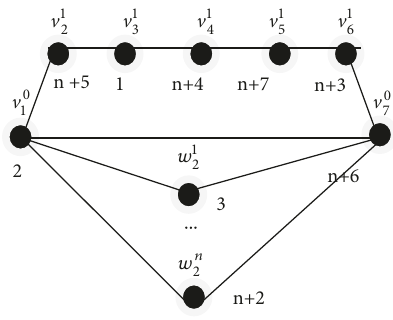
Figure 7: Bijective function 𝑔 2 (𝑥)